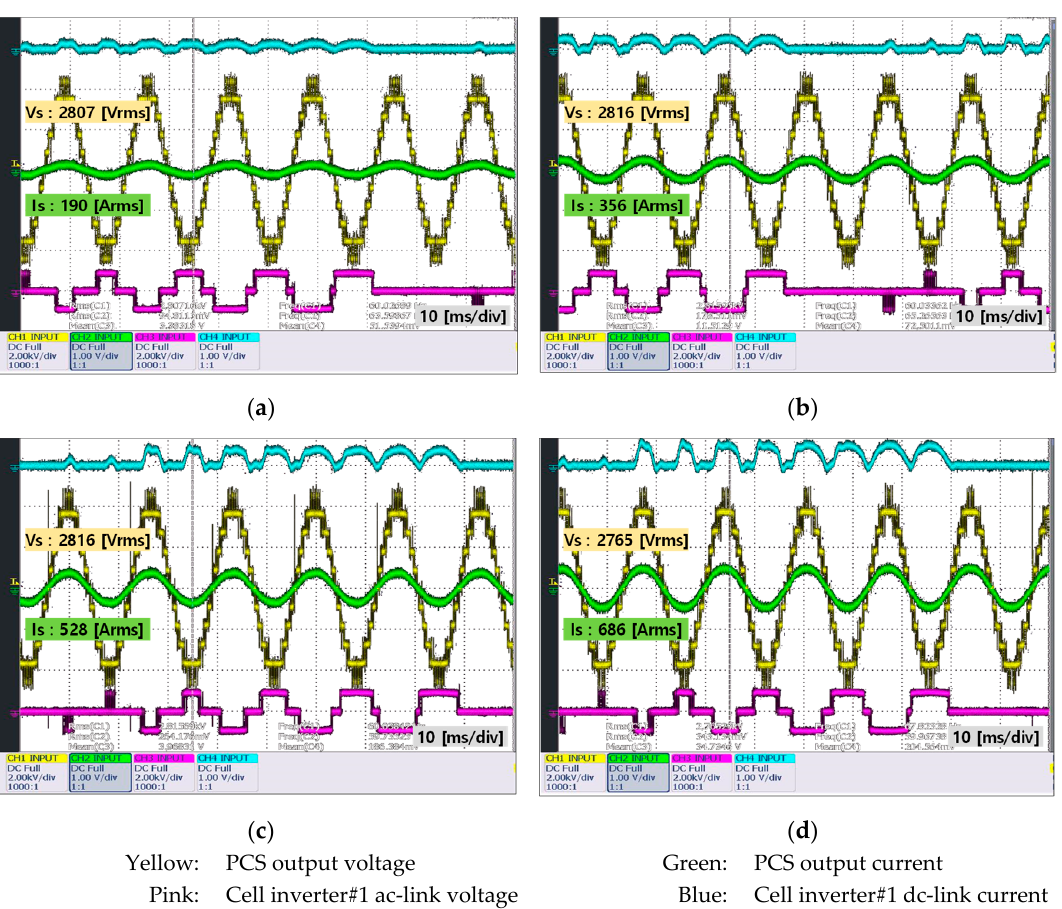
Figure 22. Results in controlling output variation: ( a ) 500 kW, ( b ) 1000 kW, ( c ) 1500 kW, ( d ) 2000 kW.